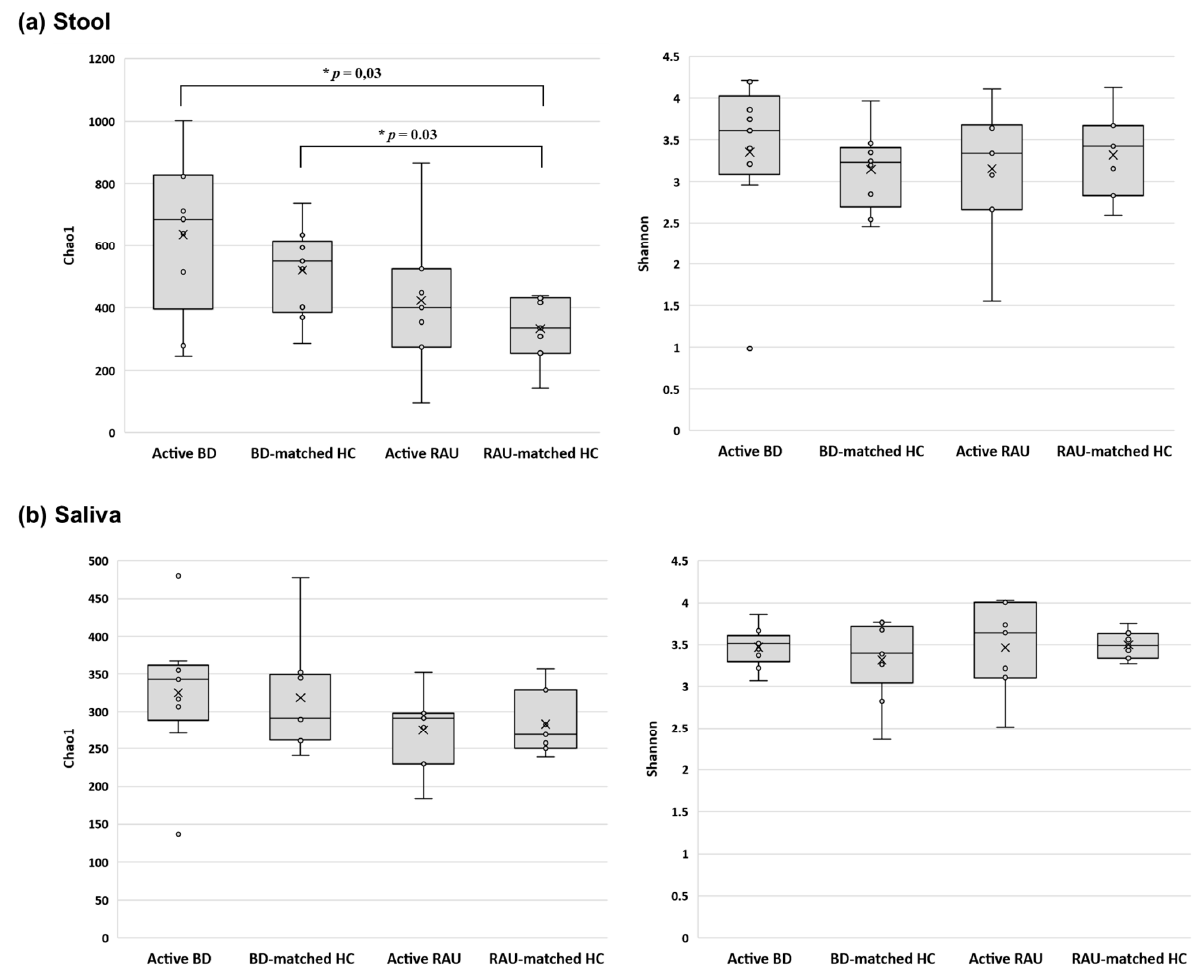
Figure 1. Comparison of the taxonomic alpha diversities of the microbiomes of active BD, BD-matched HC, active RAU, and RAU-matched HC groups. The alpha diversity indices calculated using the Chao1 and Shannon diversity indices in stool ( a ) and saliva ( b ) of the active BD group were higher than those in the BD-matched HC group; however, the difference was not statistically significant. The alpha diversity indices in the stool and saliva samples of the active RAU group were not significantly different from those of the RAU-matched HC group. On comparing the taxa in the microbiomes of patients with active BD with those of patients with active RAU, as a disease control, the alpha diversities of fecal and salivary samples were not significantly different between the two groups. However, the taxonomic richness of the micro- biome (Chao1 index) in stool of the active BD and BD-matched HC groups was significantly higher than that of the RAU- matched HC group ( p = 0.03 and p = 0.03, respectively). BD, Behçet’s disease; RAU, recurrent aphthous ulcer; HC, healthy control.